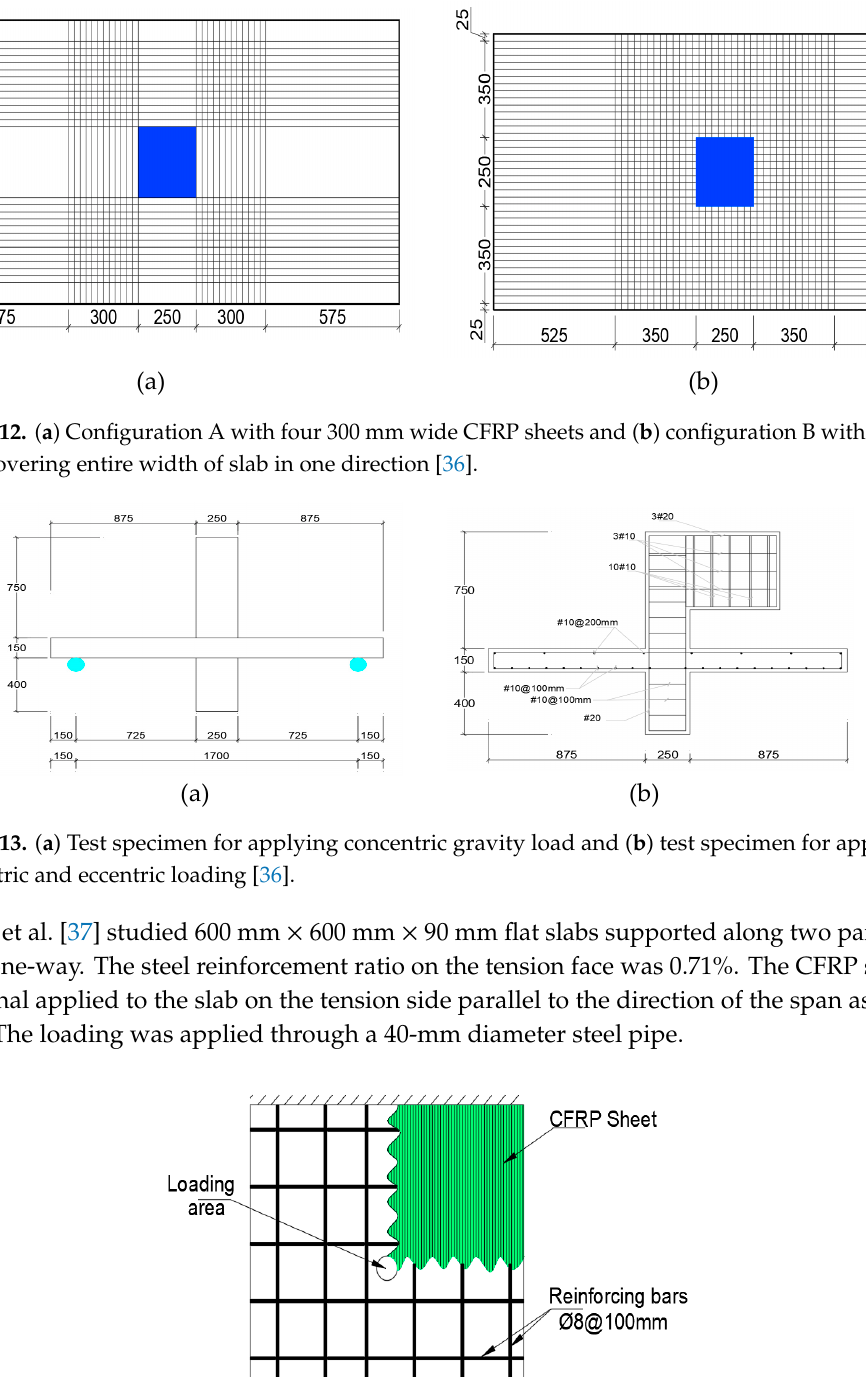
Figure 15. Load–displacement variation for punching of slabs for concrete grade B (SB: control slab; CFRP strengthened slab; and SB-T: TRM strengthened slab) [37]. Radik et al. [38] studied seven 1500 mm × 1500 mm × 152.4 mm flat slabs to evaluate the effect of strengthening on the tension side using 305 mm wide strips applied to the tension side of the slab in two perpendicular directions. Schematic of test apparatus and pattern of GFRP strips bonded to the tension face are shown in Figure 16. (a) (b) Figure 16. ( a ) Test apparatus with loading from top of the slab producing tension at the bottom, ( b ) 30.4 cm wide GFRP strips bonded to the tension face [38].